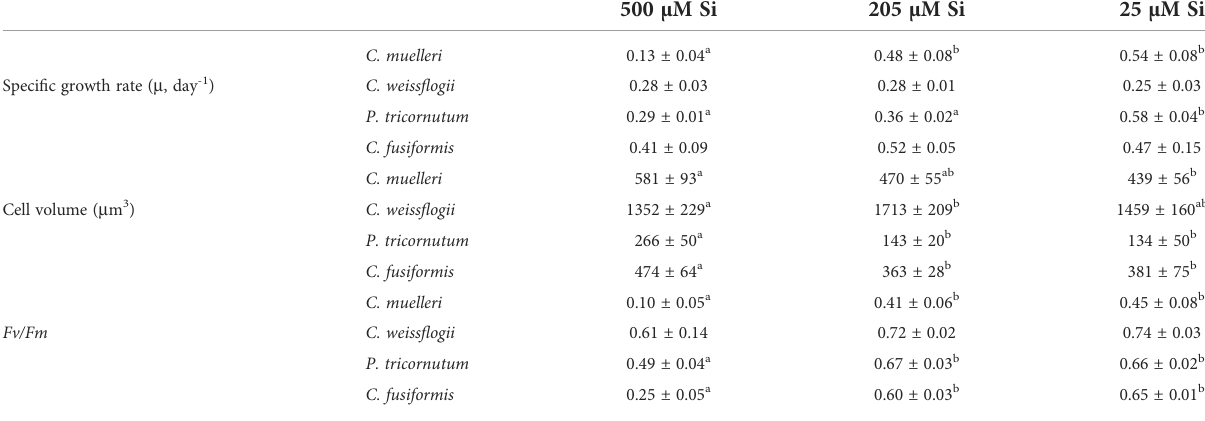
TABLE 3 Average ± SD of speci fi c growth rate ( m ), cell volume, and Fv/Fm in the four diatoms acclimated to different paleoenvironments (n ≥